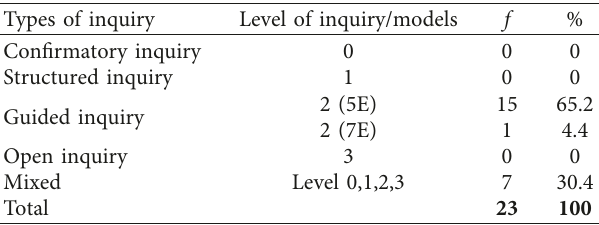
Table 4: Frequently studied inquiry types in the collected IBL papers in Ethiopia (2010 to 2021).